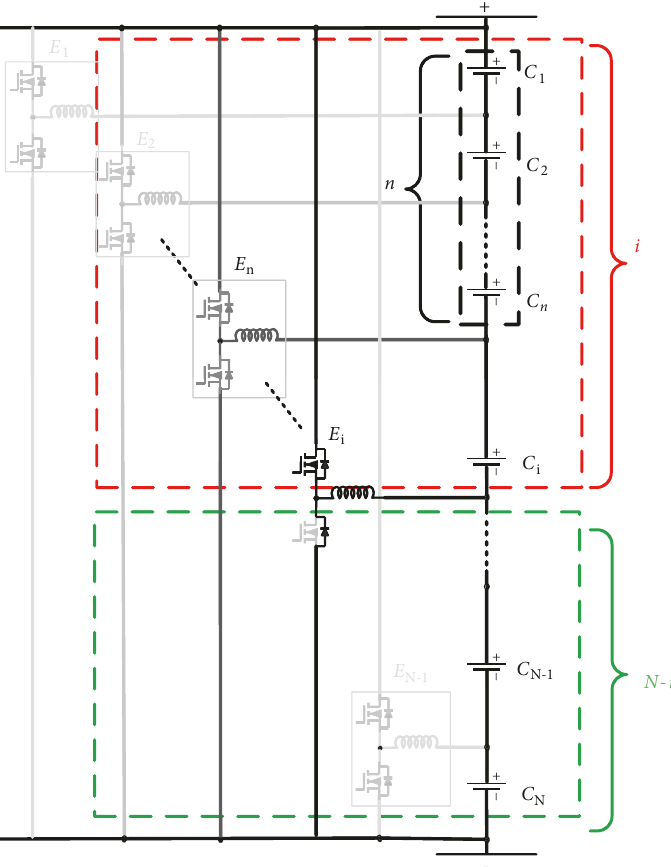
Figure 6: Energy transfer caused by the equalizer E i in situation